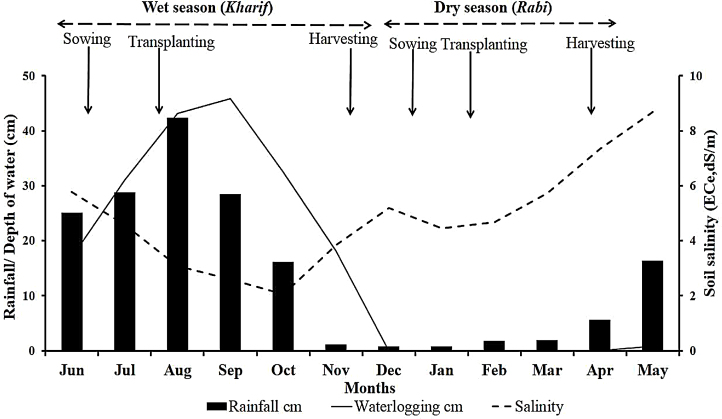
Seasonal variability in soil salinity, depth of floodwater in the field and rainfall during 2008–2014, averaged across sites and months. Arrows indicate the time of different rice cultural operations during the wet and dry seasons.